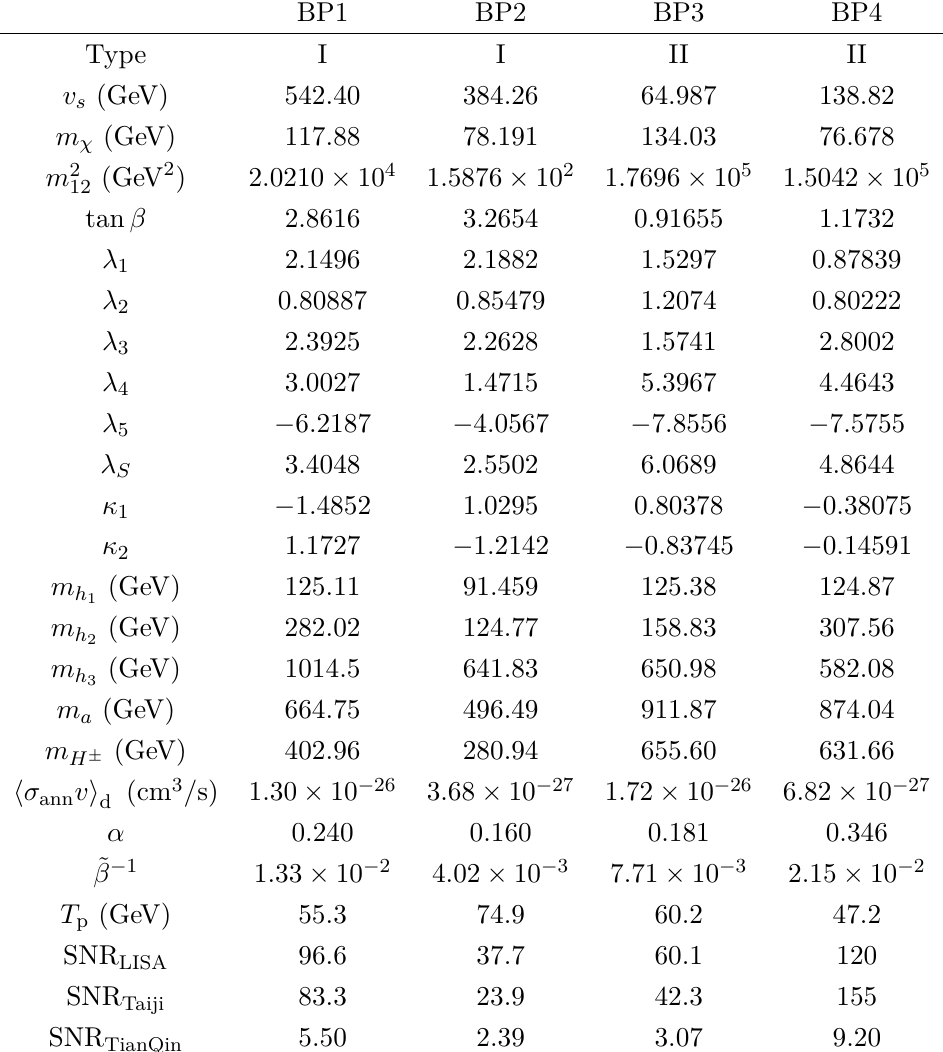
Table 1 . Detailed information for four benchmark